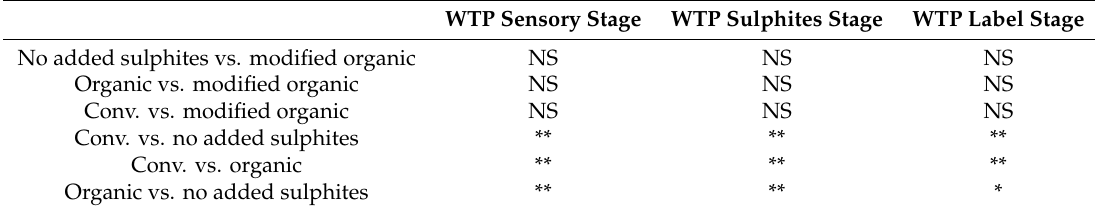
Table 8. Results of Friedman tests for comparison of WTP ranks for each wine and at each stage of the experiment for consumer group 2 (21 consumers). Friedman test, post hoc Nemenyi test; NS: not significant; * p > 0.05; ** p >